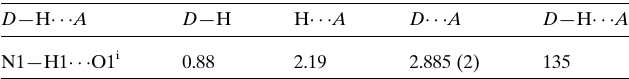
Table 1 Hydrogen-bond geometry (A˚ , (cid:2) ).